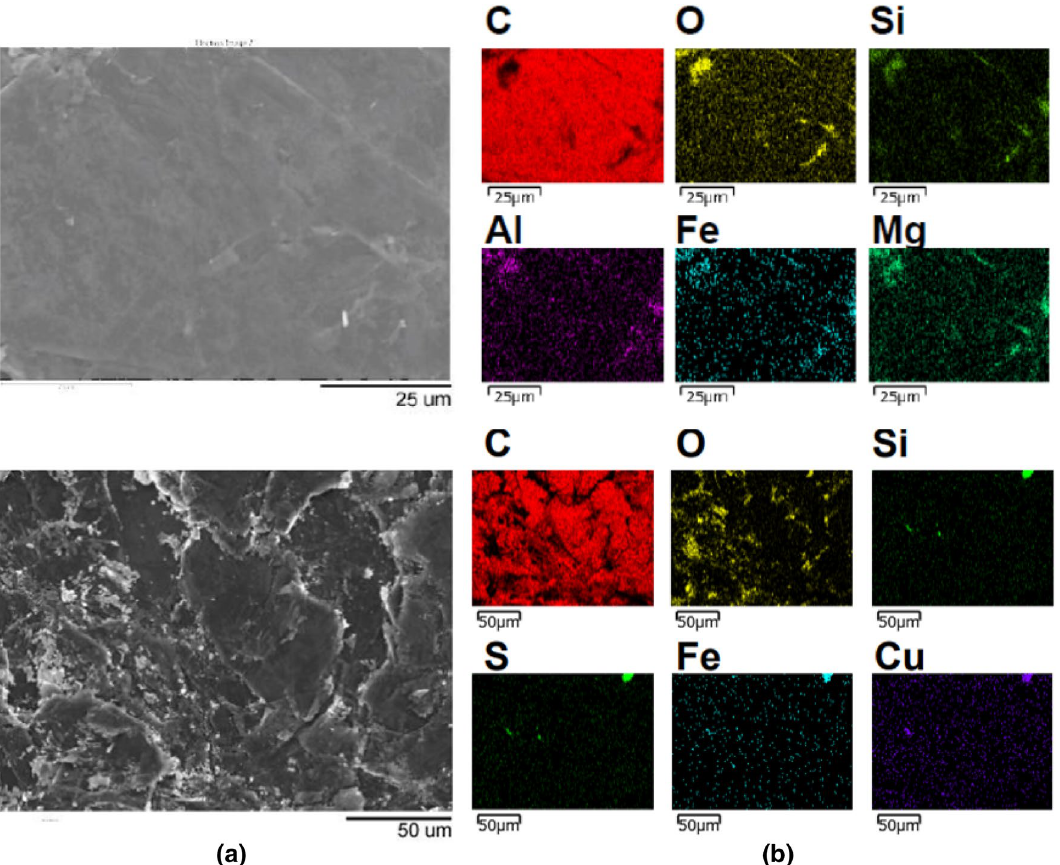
Figure 2. The ( a ) SEM images of pristine graphite samples collected from different locations and ( b ) EDX images showing elemental distributions of graphite in the two